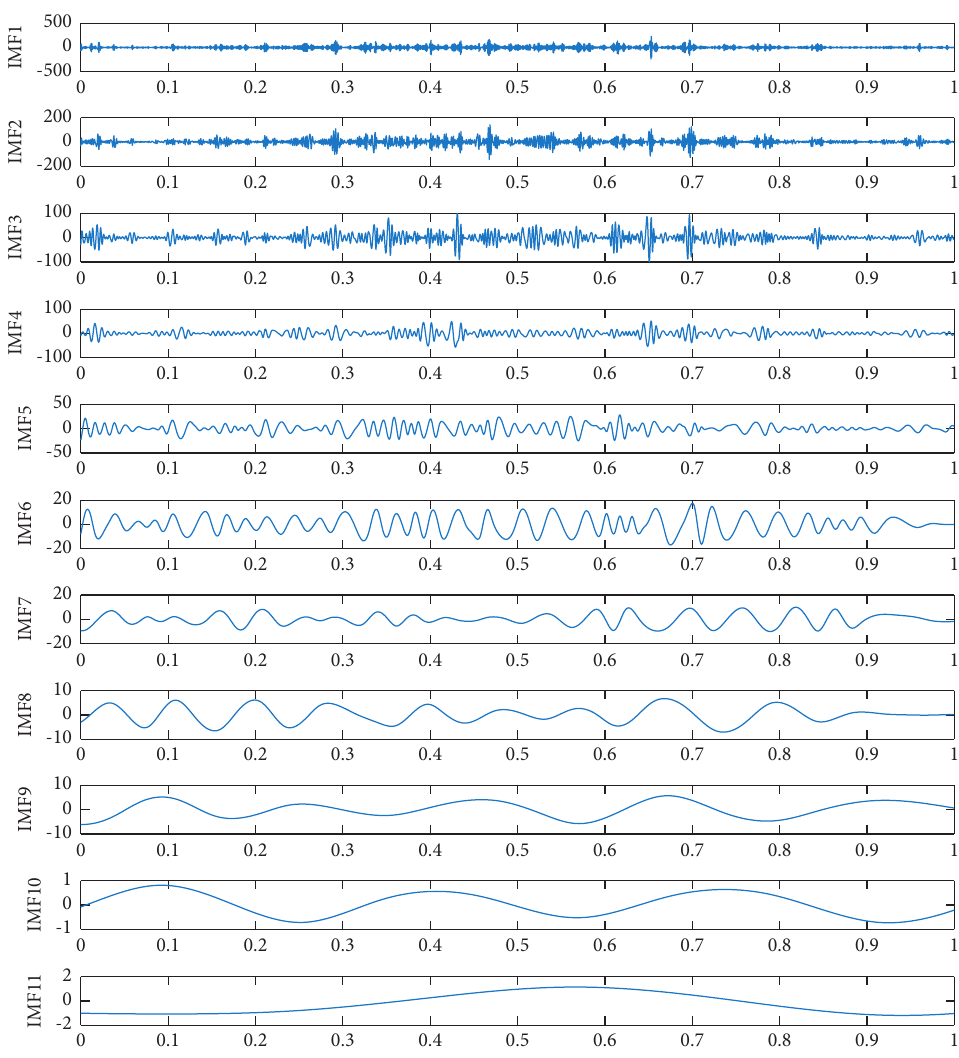
Figure 6: ICEEMDAN decomposition of the numerical simulation of outer ring